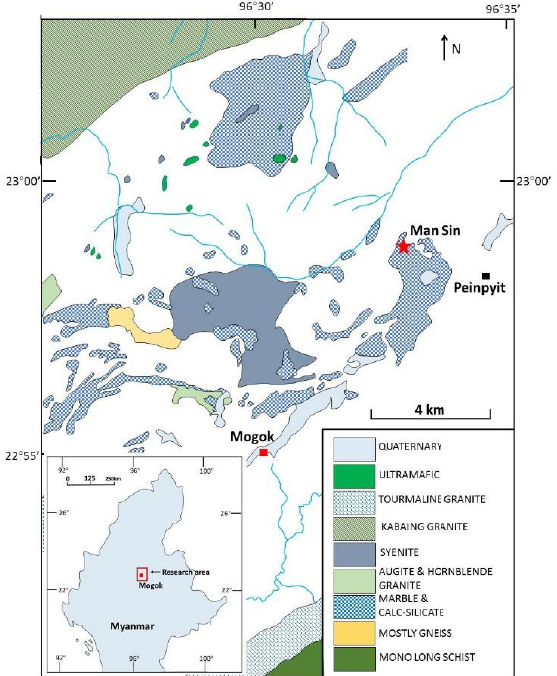
Figure 1. Geological map of the Mogok and Man Sin area (Modified from [8,11,13]).